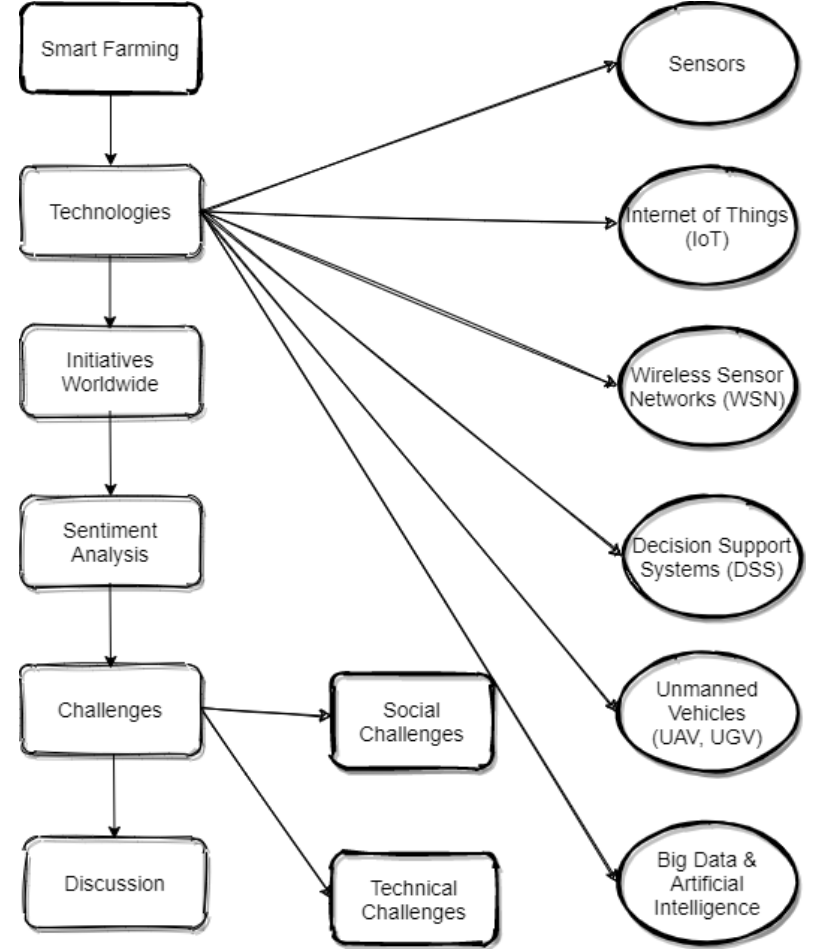
Figure 2. Structure of the